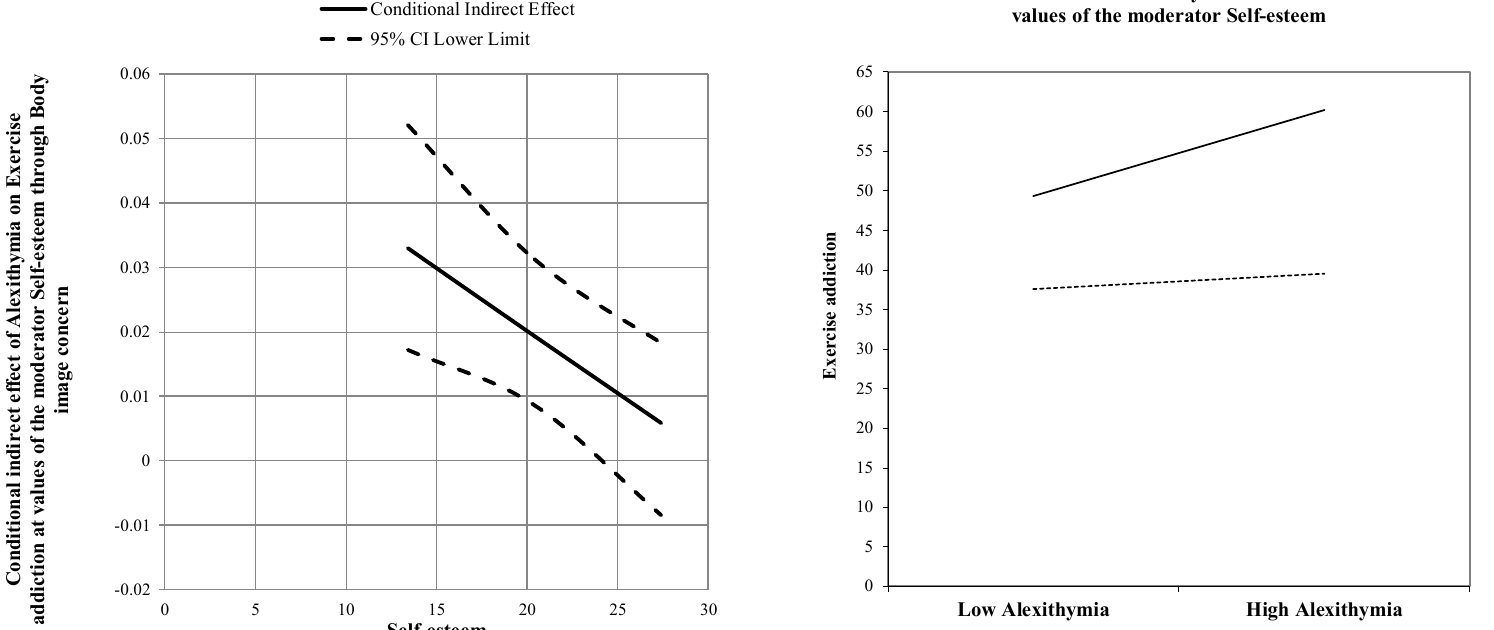
Figure 2. Graphical representation of the moderation effect.